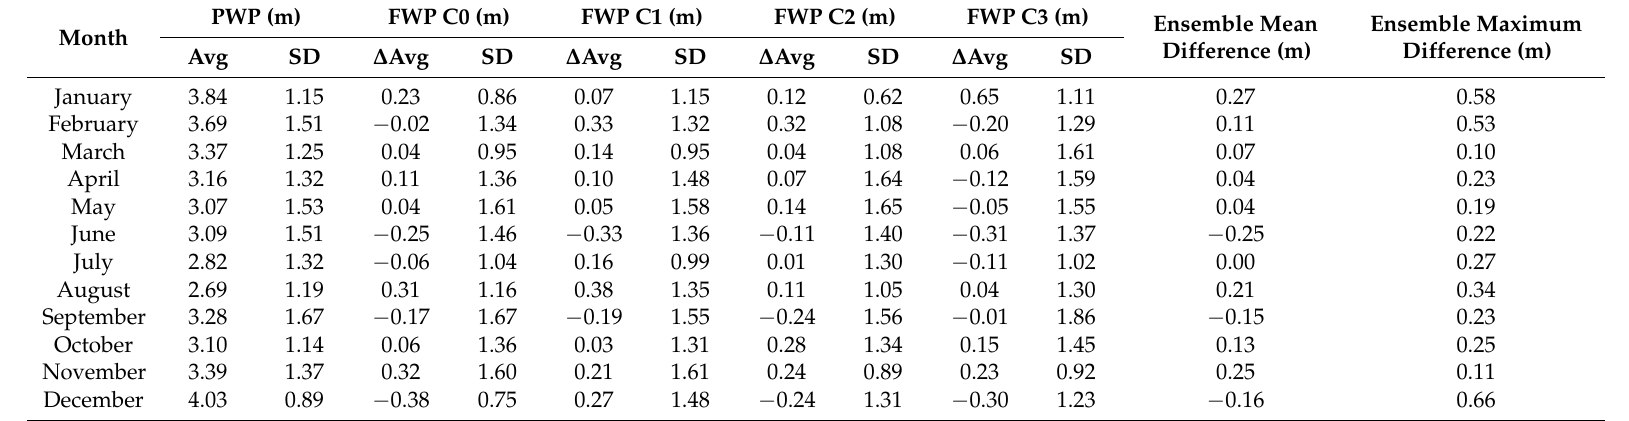
Table 2. West Gabbard comparison of present (PWP) and future (FWP-C0–C3) H s max